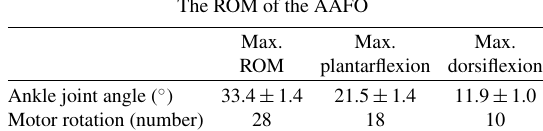
Fig. 5. Flow chart of gait event